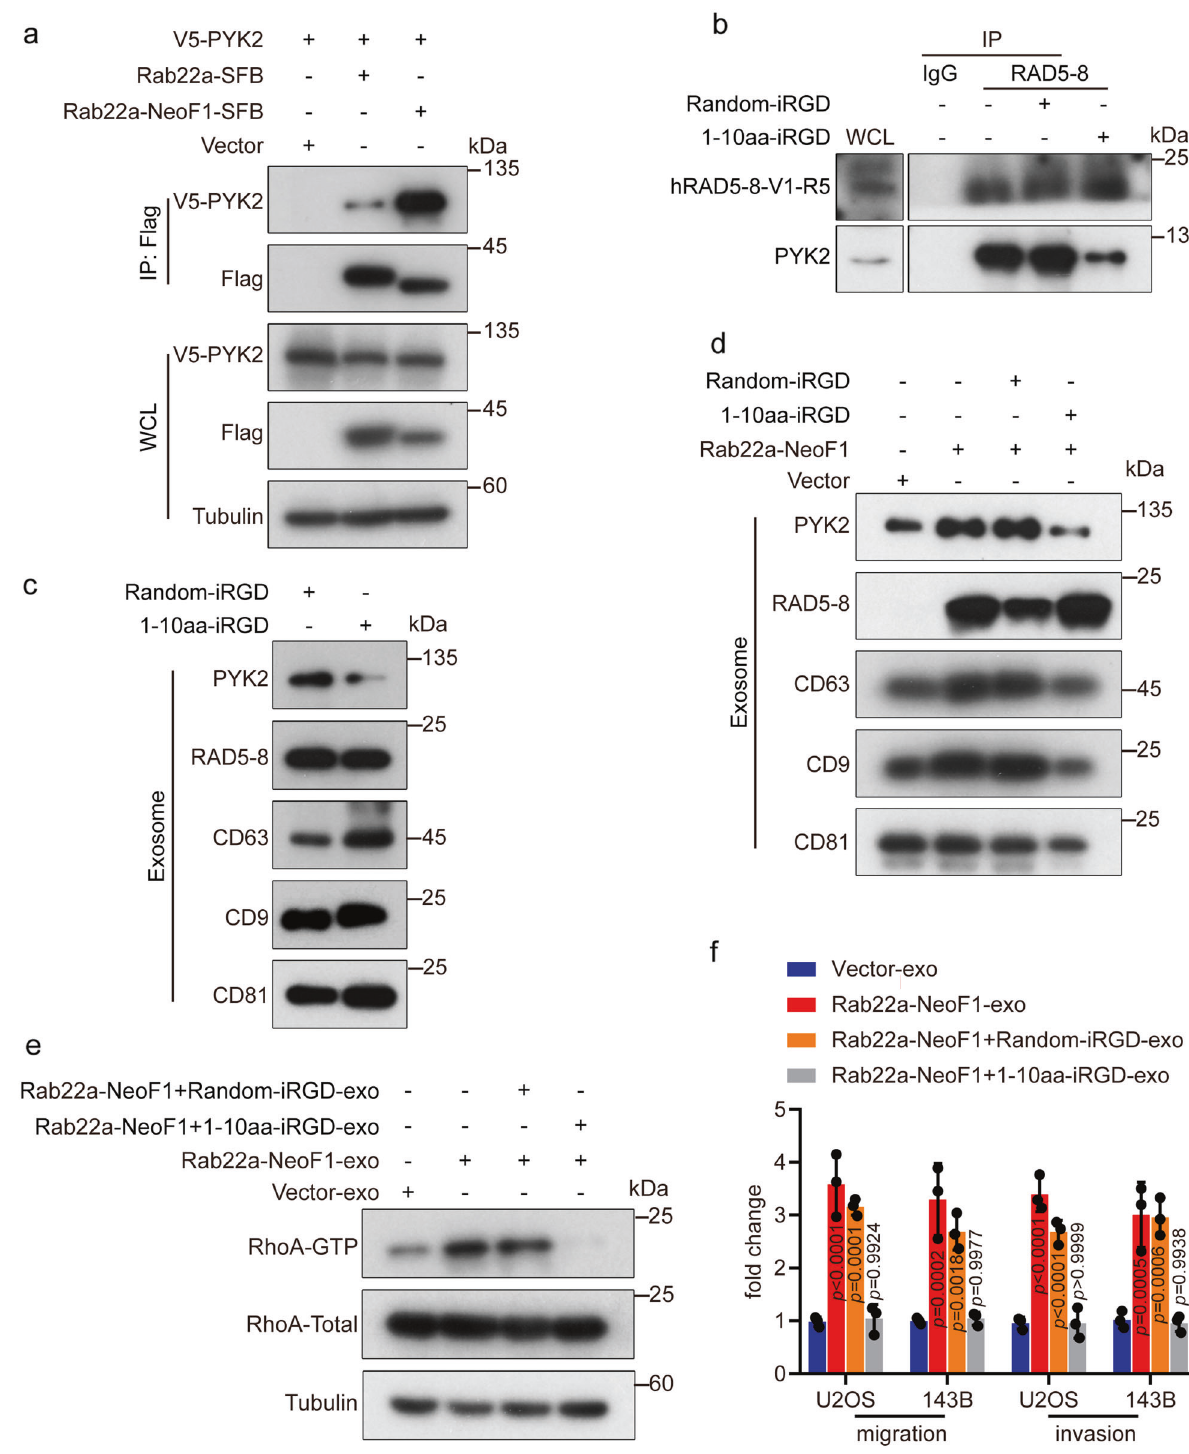
Fig. 7 Blockage of the interaction between Rab22a-NeoF1 and PYK2 inhibits the RhoA activation, migration, and invasion of the recipient cells induced by the exosomal Rab22a-NeoF1 fusion protein. a The 293T cells were co-transfected with the indicated plasmids and then were lysed and analyzed by immunoprecipitation using anti-Flag beads followed by Western blotting. b ZOS-M cells were incubated with the indicated peptide for 24 h, and then were lysed and subject to immunoprecipitation using anti-IgG or anti-mAb RAD5 – 8, followed by Western blotting. WCL whole-cell lysate of ZOS-M cells. c , d ZOS-M cells ( c ) and the indicated stable 143B cells ( d ) were treated with the indicated peptide for 24 h, and then the exosomes were puri fi ed and analyzed by Western blotting. e U2OS cells were incubated with the indicated exosomes for 1 h and then were lysed and subjected to RhoA activation assay. Data in a – e are representative of n = 3 biologically independent experiments. f U2OS and 143B cells were treated with the indicated exosomes for 24 h, and then were subjected to migration and invasion assays. Data are mean ± s.d. of n = 3 biologically independent experiments. P values are shown